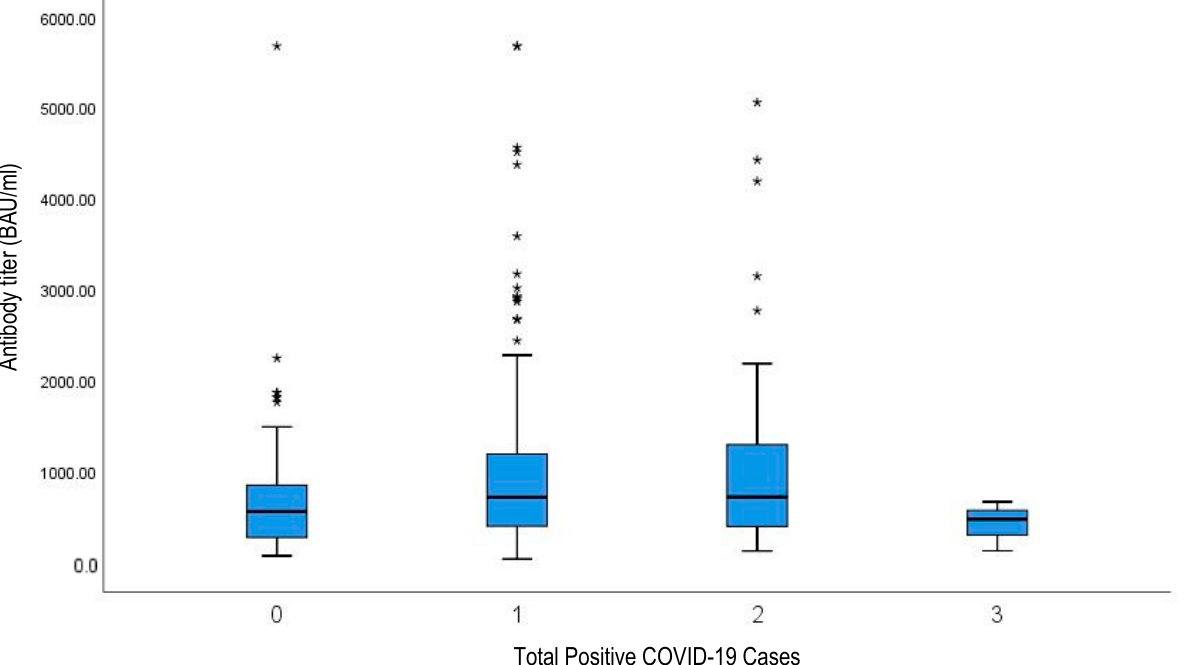
Figure 6. Distribution of antibody titer in correlation to total positive COVID-19 cases before and after booster. As seen in the figure, increased antibody levels were observed in participants who had confirmed COVID-19 cases 0, 1, or 2 times, but lower levels were observed in participants who had contracted COVID-19 3 times. ( * outliers / antibody titer with extreme value)